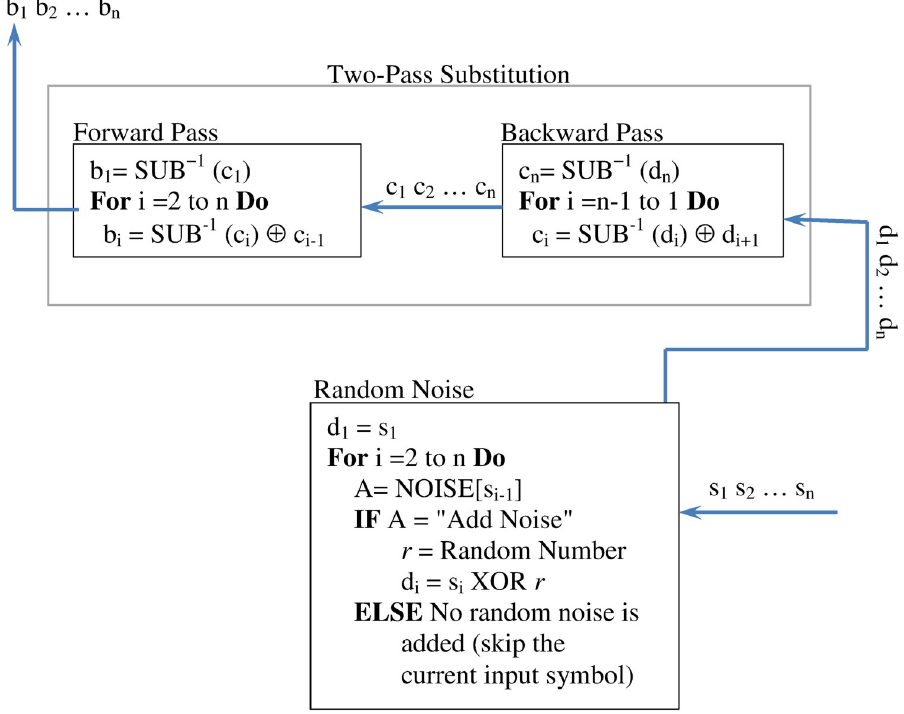
Fig 10. The dual diffusion inverse method: The processing instructions and the flow of